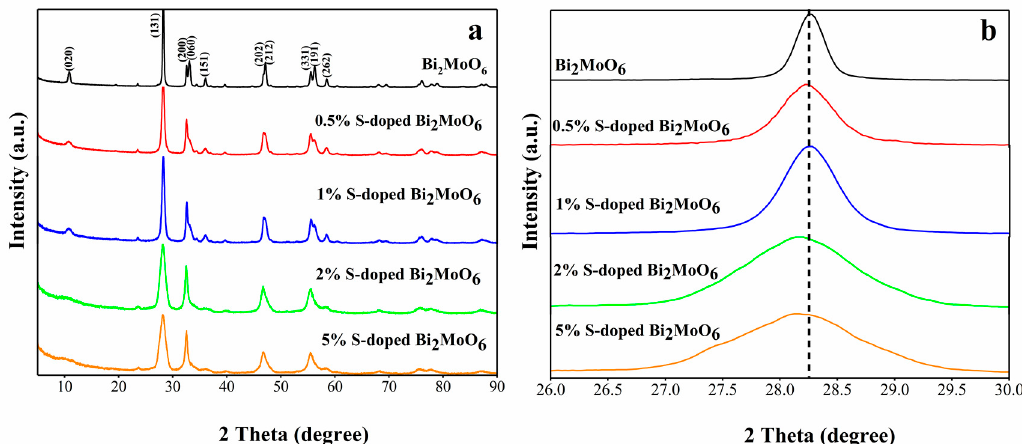
Figure 2. X-ray diffraction (XRD) patterns of samples: ( a ) S-doped Bi 2 MoO 6 , ( b ) local magnification of (131) crystal lane.